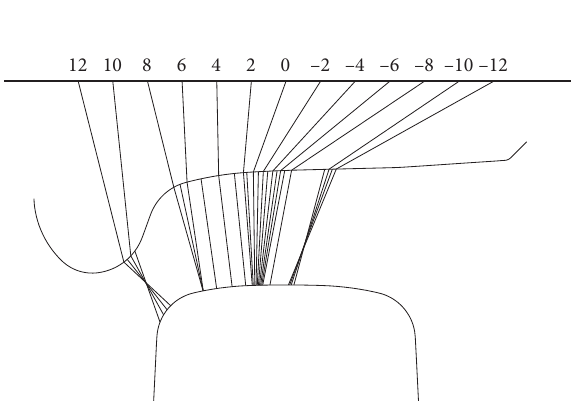
Figure 10: Wheelset contact angle.